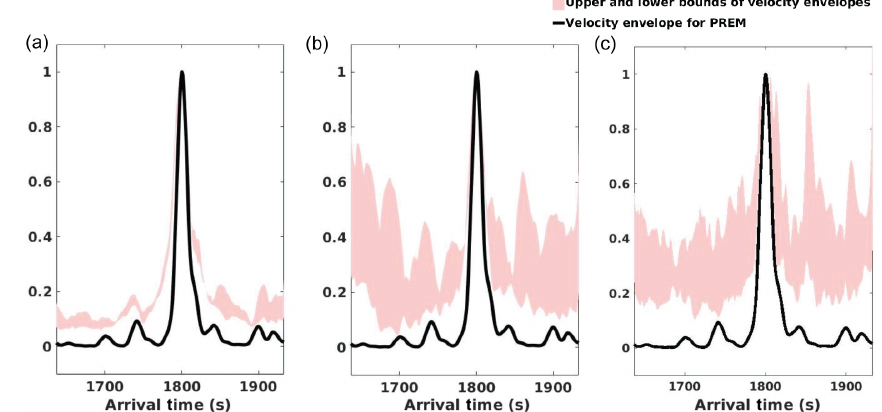
Figure 6. Upper–lower bounds of coda envelopes (shaded area) calculated from five random heterogeneity realizations of MODEL 2 (a) , MODEL 4 (b) and MODEL 5 (c) , compared to PREM (black line). Table 2. Estimated relative contributions to apparent 1 /Q ScS . ACF indicates an autocorrelation function.